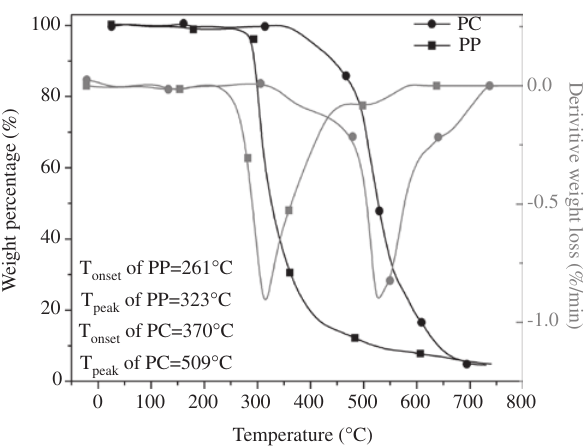
Figure 1: Effect of temperature on weight change (TGA plot of virgin PP and